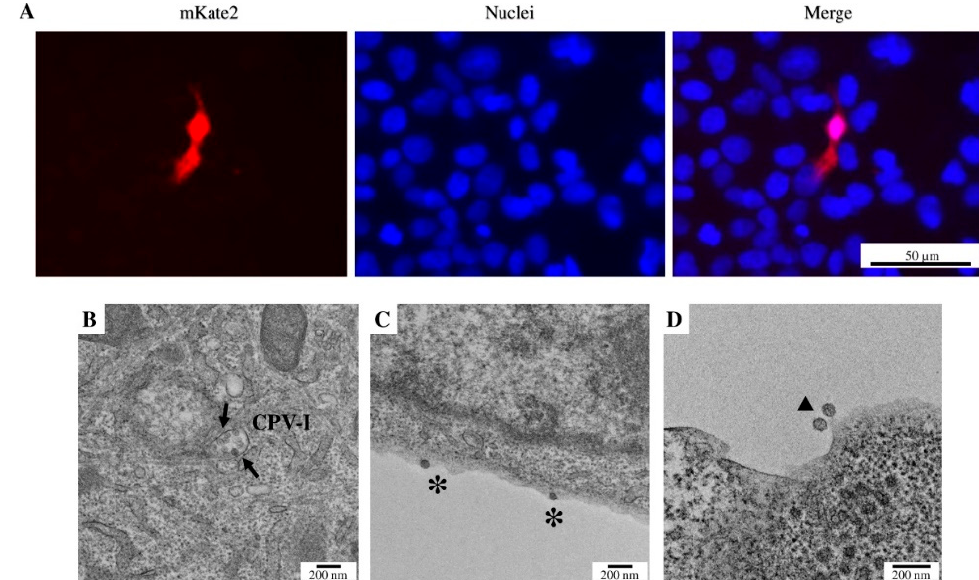
Figure 5. HEK-293T cells from the entry assay infected with the particles generated with the pACNR-Rep and pVax-Help system in ( A ) fluorescent-field mKate2 expression (Texas Red filter), nuclei stain (DAPI filter), and ( C ) overlap of mKate2 and nuclei micrographs, demonstrating that the particles generated by the co-transfection of both plasmids result in the expression of the gene of interest (mKate2) in the target cells. The bar indicates the same scale for all images, 50 µm. HEK-293T cells 48 h post-transfection with replicon and helper system were observed by transmission electron microscopy (TEM). ( B ) Cytopathic vacuole type 1 (arrow, CPV-I), ( C ) two virions budding from a membrane ( * ), and ( D ) two extracellular virions ( ▲ ). Bar B–D, 200 nm.